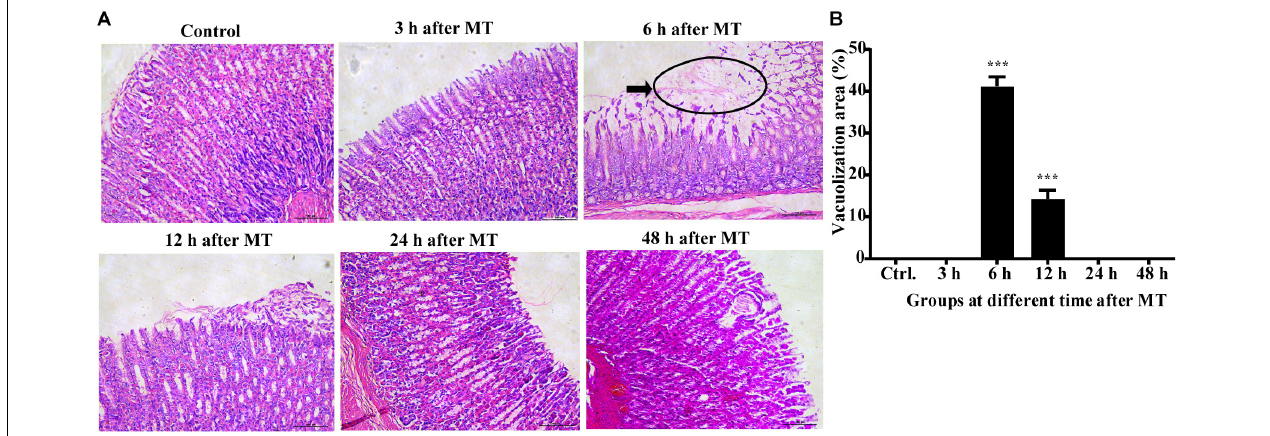
FIGURE 1 | Changes in the gastric mucosa at different times after MT (200 × ). (A) HE staining of the stomach of the SD rats at different time points after MT. The black area shows obvious vacuolated changes at 6 and 12 h after MT. No obvious changes were observed in the control, 3, 24, and 48 h groups. (B) Mean ( ± SEM) percentages of morphologically vacuolized areas at 6 and 12 h (*** P < 0.001 vs. the control).